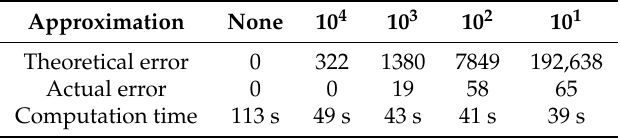
Table 9. Theoretical and actual error in the computation of the first Betti number by skipping the reduction of columns that require certain numbers of reduction steps. The cell counts are 4656, 35,587, and 1,485,099 in dimensions 0,1 and 2 respectively, and the first Betti number is 3321. The computations were made as averages over ten runs on a MacBook Pro, 2.5 GHz Intel Core i7. Source of data: Blue Brain Project—Layer 4 of the neocortical column reconstruction, Version